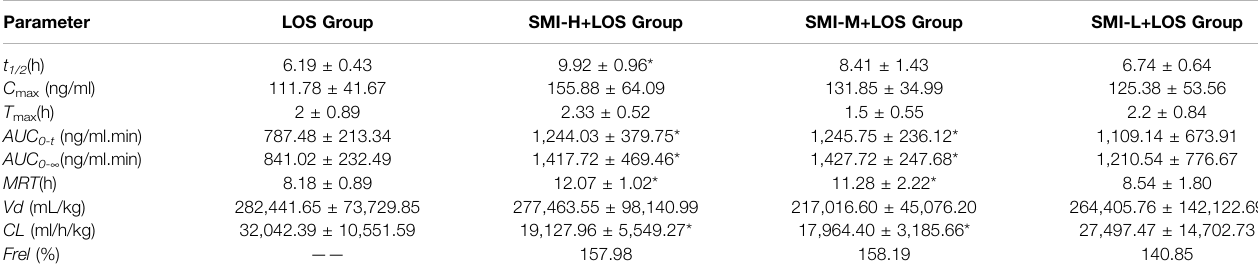
TABLE 1 | The pharmacokinetic parameters of LOS in each group with L-NAME treatment. *i indicates p < 0.05 compared with LOS group. Parameter LOS